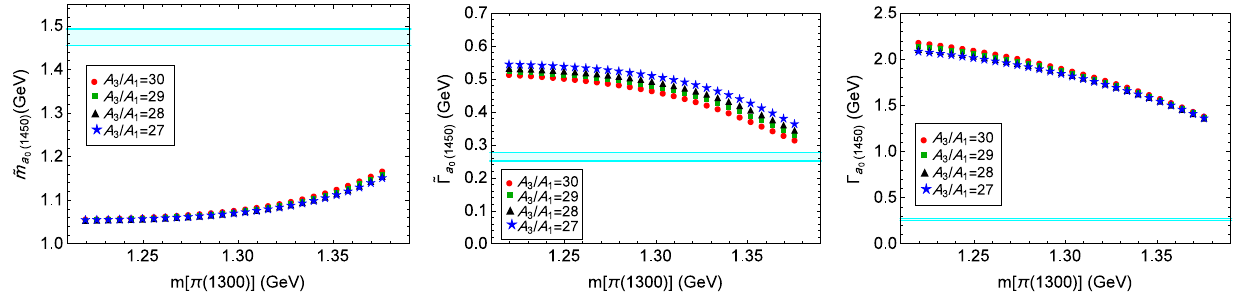
Fig. 17 Physical mass (left) and decay width (middle) of the second isovector scalar meson extracted from the second pole of the unitarized πη elastic scattering amplitude are compared with the corresponding experimental ranges (shaded) for a 0 ( 1450 ) reported by PDG [145]. While unitarity corrections drop the mass of a 0 ( 1450 ) below its exper-